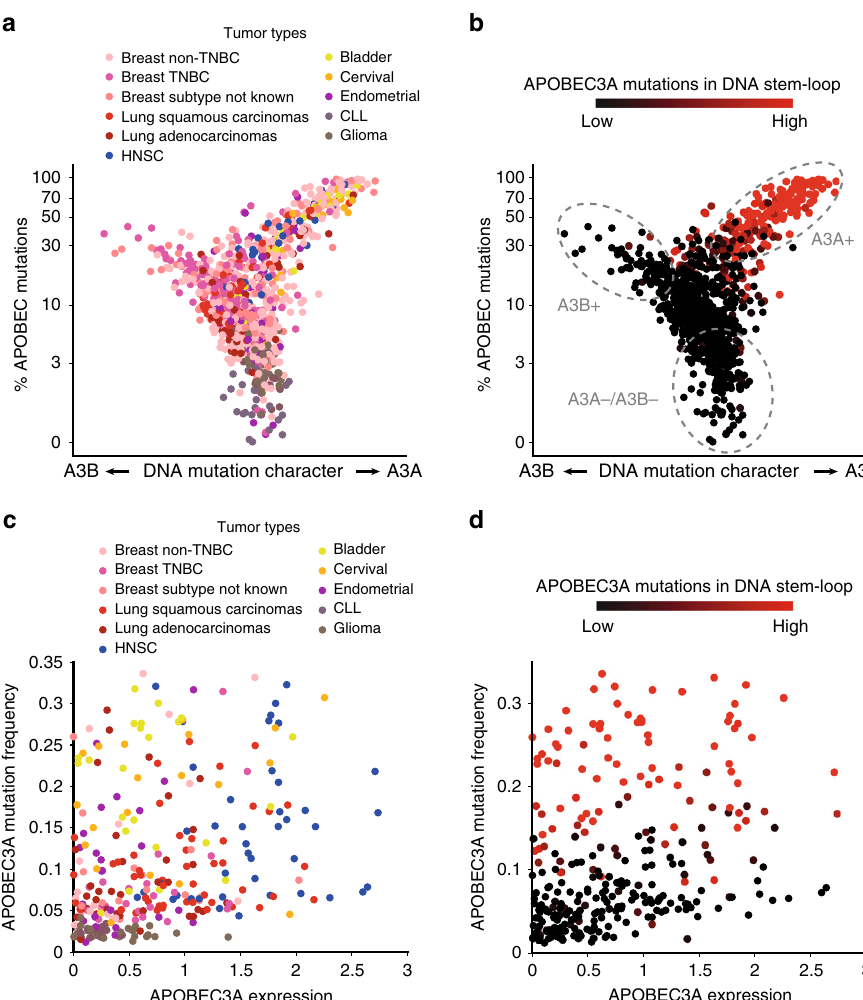
Fig. 1 APOBEC3A and APOBEC3B mutation landscape in patients ’ tumors. a , b Whole Genome Sequencing (WGS) of patient tumor samples (from TCGA and other projects, see Supplementary Table 1) were analyzed for their mutation frequency in the TpC motif. Each patient ’ s tumor samples were plotted by their level of mutations in the TpC motif and their mutation frequency in RTC versus YTC sequences. c , d Patients ’ tumor samples were plotted according to their A3A expression level and mutation frequency in YTC sequences. Color-codes indicate patients ’ tumor types ( a , c ) or APOBEC3A mutation frequency in DNA stem-loops ( b , d